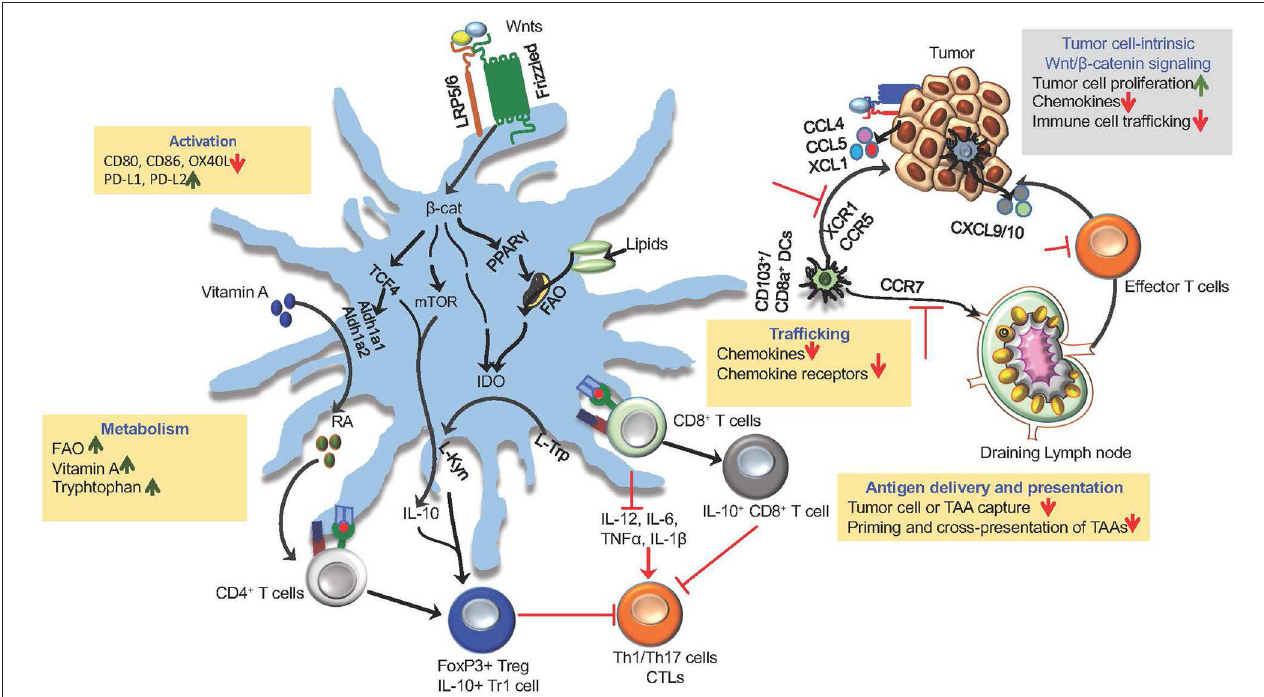
FIGURE 2 | Wnt/ β -catenin signaling in DCs and tumors in driving immune suppression and immune evasion. The canonical Wnt signaling shape anti-tumor immune responses by modulating DC functions, such as activation, trafficking, capturing and cross-presenting TAAs and expression of immune regulatory factors (RA, IL-10, IDO, TGF- β ). Activation of β -catenin and its down-stream mediators mTOR and TCF4 in tumor DCs through Wnt-LRP5/6 signaling leads to the induction of anti-inflammatory factors RA, IDO, and IL-10 that are critical for promoting Treg response to tumor antigens. Wnts regulate trafficking of DCs to tumor and tumor-draining lymph nodes (TDLNs) by regulating the expression of chemokine receptors CCR5, XCR1, and CCR7. Within the TME, DC-intrinsic Wnt signaling limits the recruitment of CTLs by suppressing the expression of chemokines CXCL9/10. Wnt signaling leads to metabolic alterations in DCs that programs them to a regulatory state. Wnt- β -catenin-PPAR γ - mediated signaling shifts DC metabolism from glycolysis to FAO by upregulating the expression of the carnitine palmitoyltransferase-1A (CPT1A) fatty acid transporter. In addition, Wnt- β -catenin-TCF signaling in tumor DCs promote vitamin A metabolism through the induction of enzymes involved in RA synthesis and tryptophan metabolism through the induction of IDO. The canonical Wnt signaling pathway in tumor cells promotes tumor growth and immune evasion via chemokines (CCL4, XCL1, CCL5) that are critical for the recruitment and accumulation of DCs within the TME.